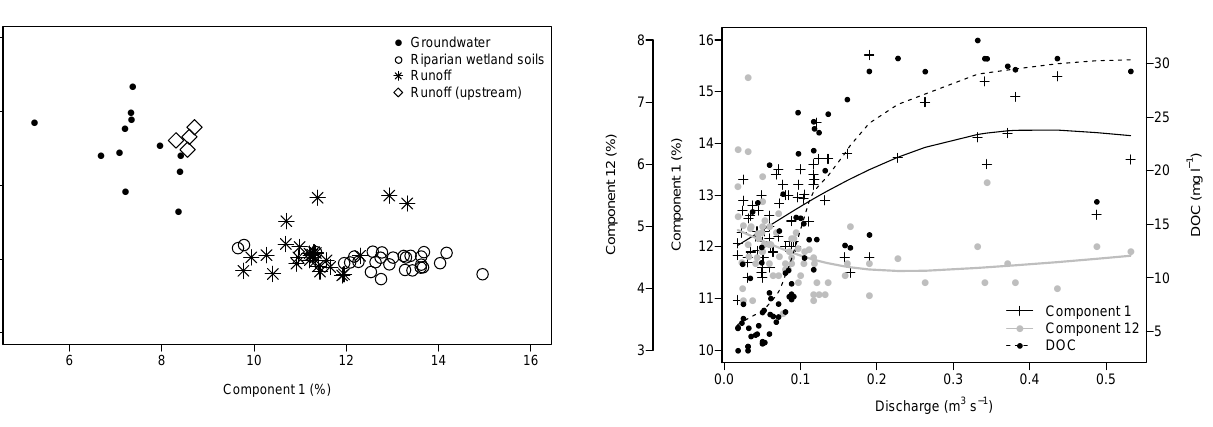
Fig. 6. DOC concentration and quality parameters in response to discharge. The lines for components 1 and 12 were fitted using the R function smooth.spline and 3 degrees of freedom. The line for DOC concentrations was fitted using the R function lowess with a smoothing span of f = 0 .